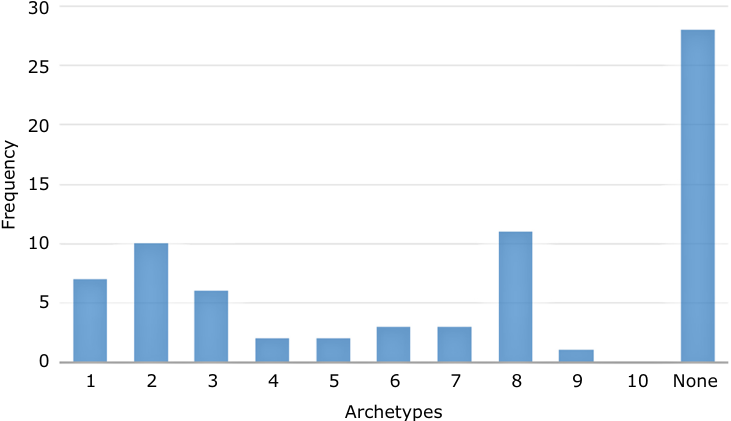
Fig. 4. Addressed system archetypes